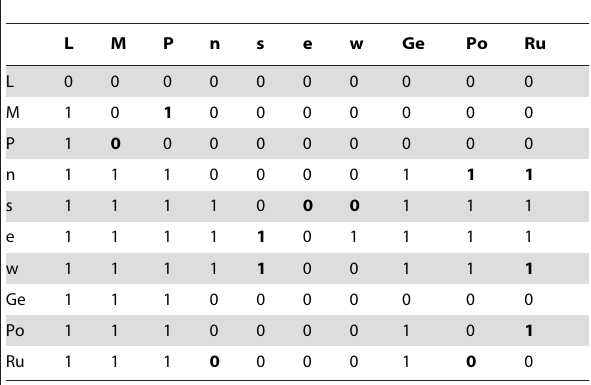
Table 3. Ordinal relation of similarity differences represented as a connection matrix C S London for London relative to the set of words { London, Moscow, Paris, north, south, east, west, Germany, Poland, Russia } shown by initial letters, derived from the WordNet data in Figure